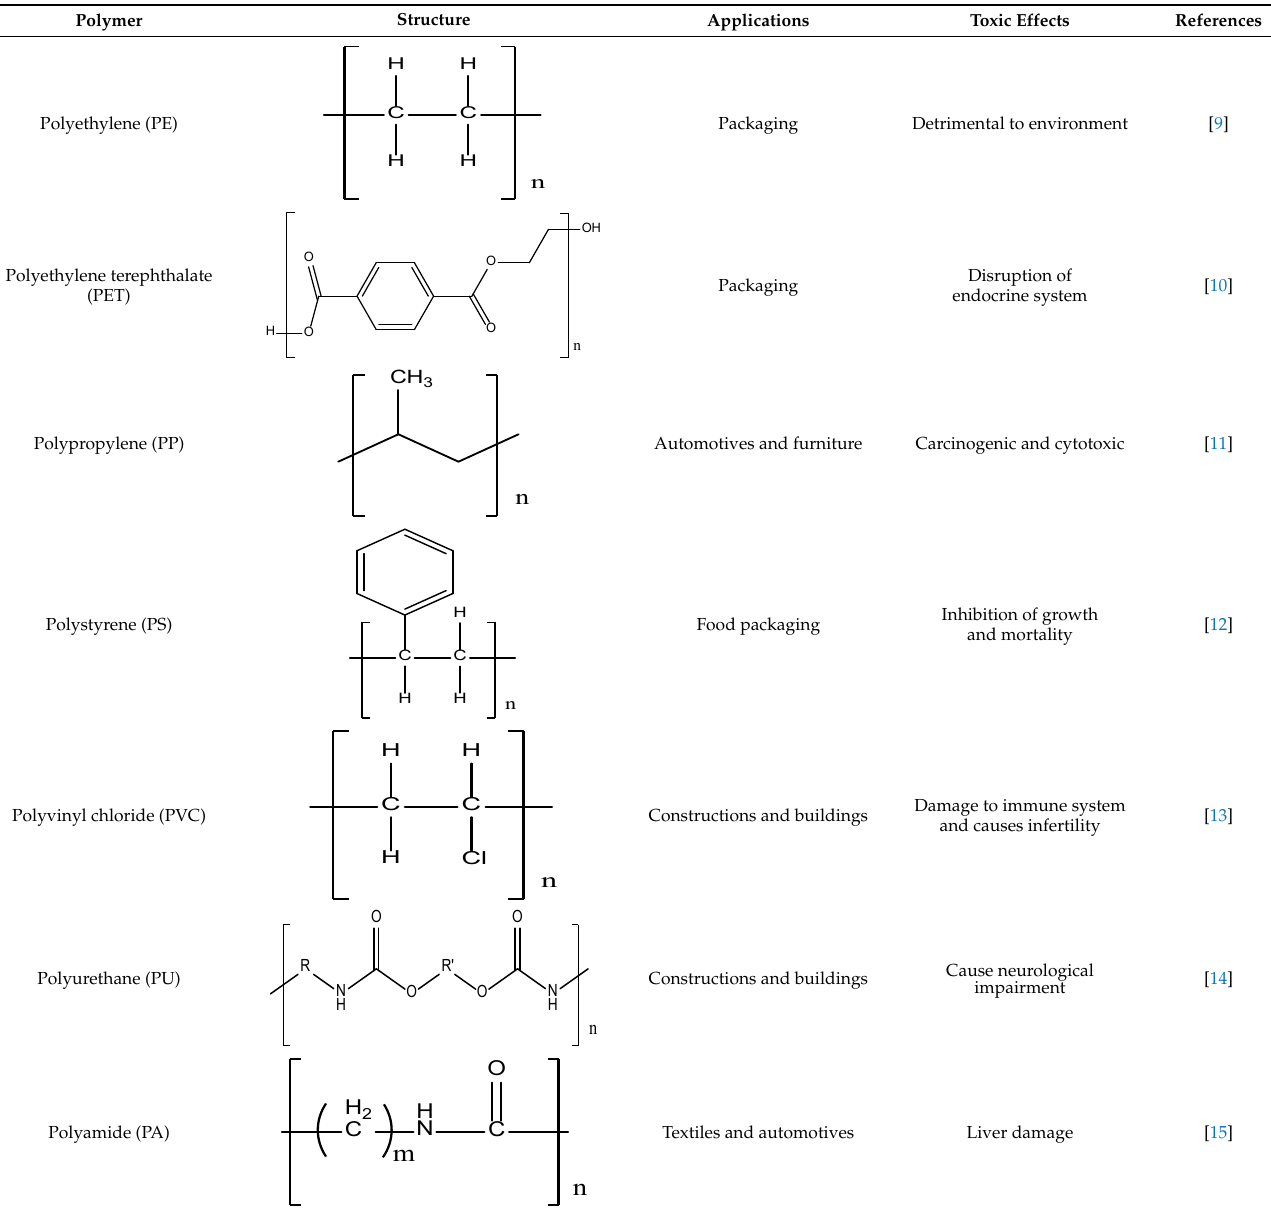
Table 1. Applications and hazards associated with commodity microplastics.